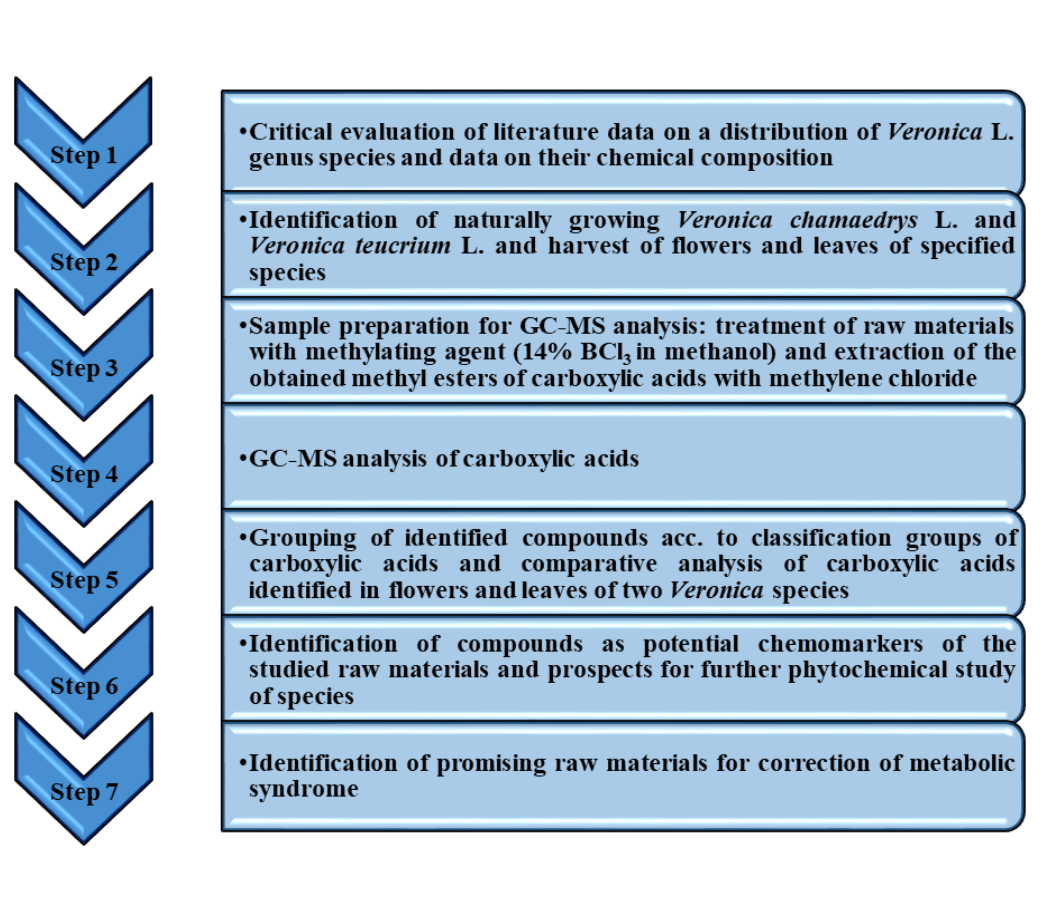
Fig. 1. Planning of the